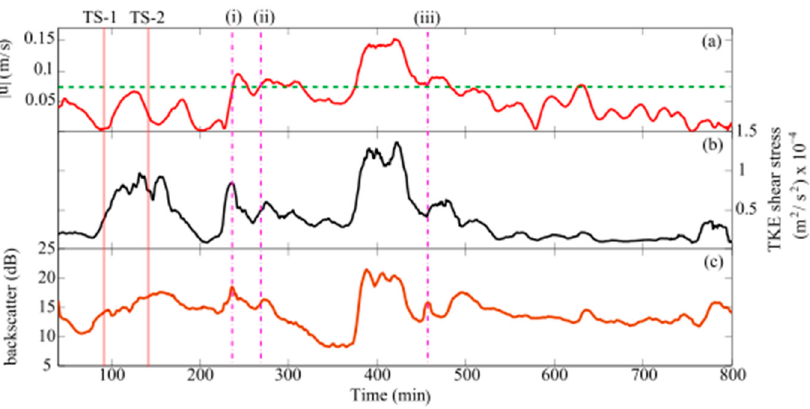
Figure 6. Time series showing: ( a ) 1 min averaged velocity streamwise velocity, ( b ) turbulent kinetic energy (TKE) shear stress, and ( c ) backscatter. The horizontal line shown in ( a ) represents the critical velocity value for suspension. Reprinted with permission from [22]. 2021 Hanmaiahgari, P.R.